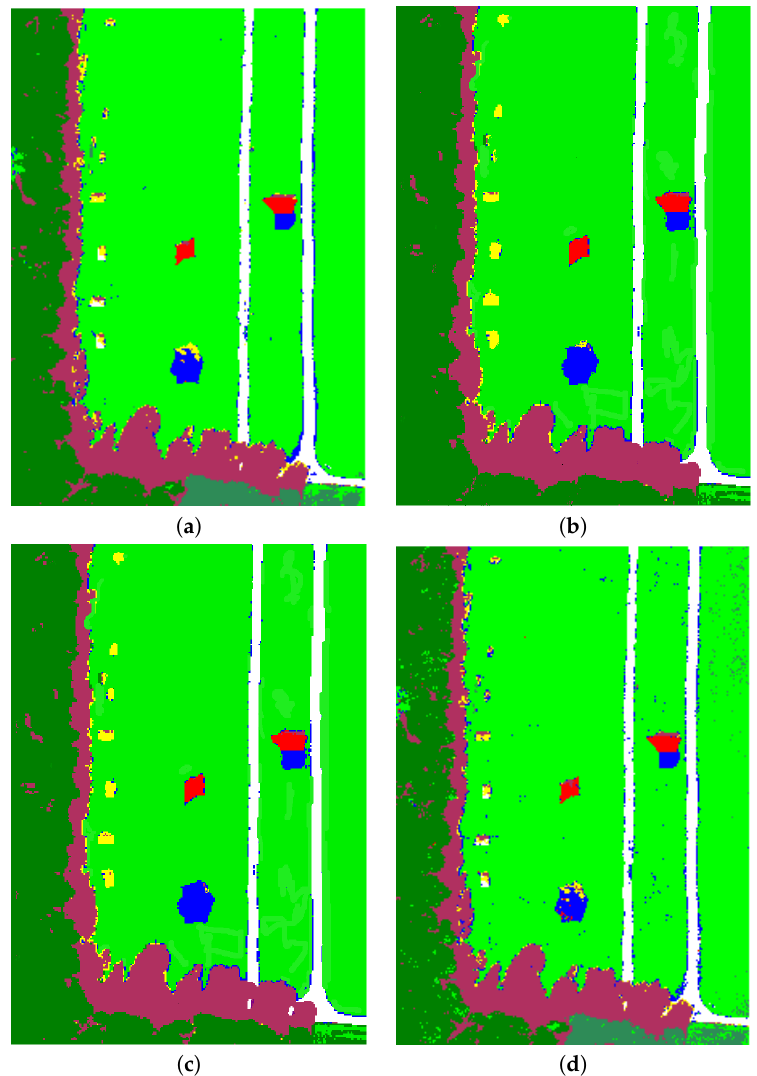
Figure 15. Classification results of the HYDICE HSI after denoising by: ( a ) SDNW-MLR; ( b ) SDNW-MWF; and ( c ) SDNW-MWPT-MWF. The classification result without denoising ( d ) is supplied as a benchmark. ( SNR INPUT = 30